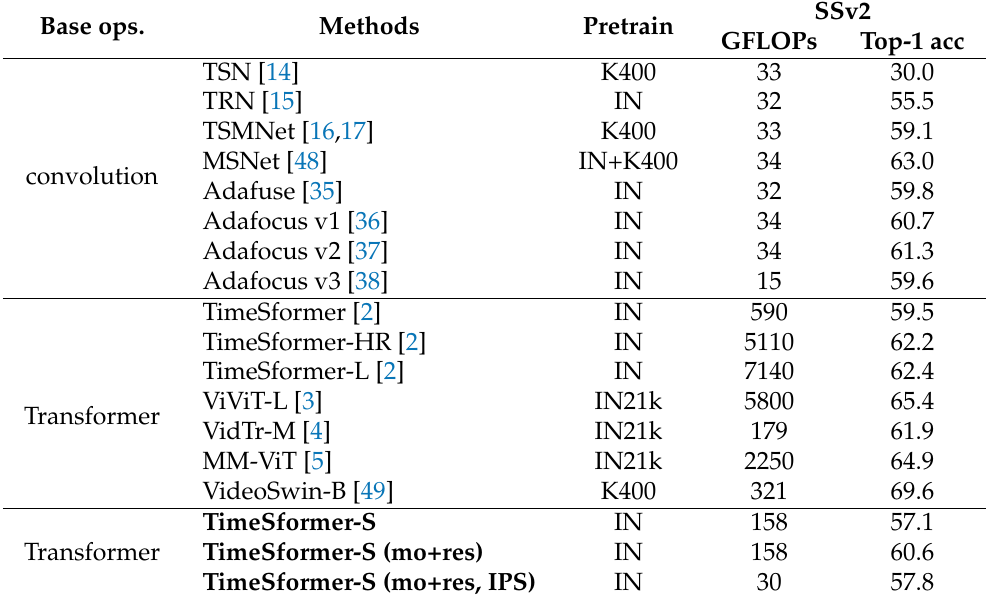
Table 5. Comparison with state-of-the-art methods on SSv2. ”IN” and ”IN21k” represent ImageNet and ImageNet-21k [53,54], respectively. ”K400” denotes Kinetics-400 [19]. Our methods appear in boldface. ”mo+res” stands for taking P-frames as motions and residuals. All of our methods take 24 frames with the frame size of 144 × 144 and